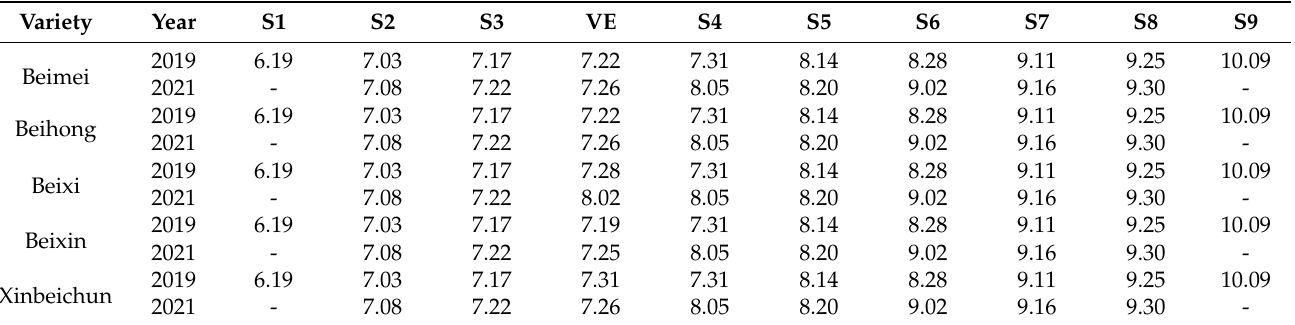
period. The grapevines were spaced 0.8 m apart within the row and 3.5 m apart between rows with a North-South row orientation, and managed by traditional management. Moreover, the grapevines are nine years old and their yield is 6000 kg/ha. Table 1. Sampling date at different developmental stages of ‘Beimei’ and other wine grape varieties in 2019 and 2021.